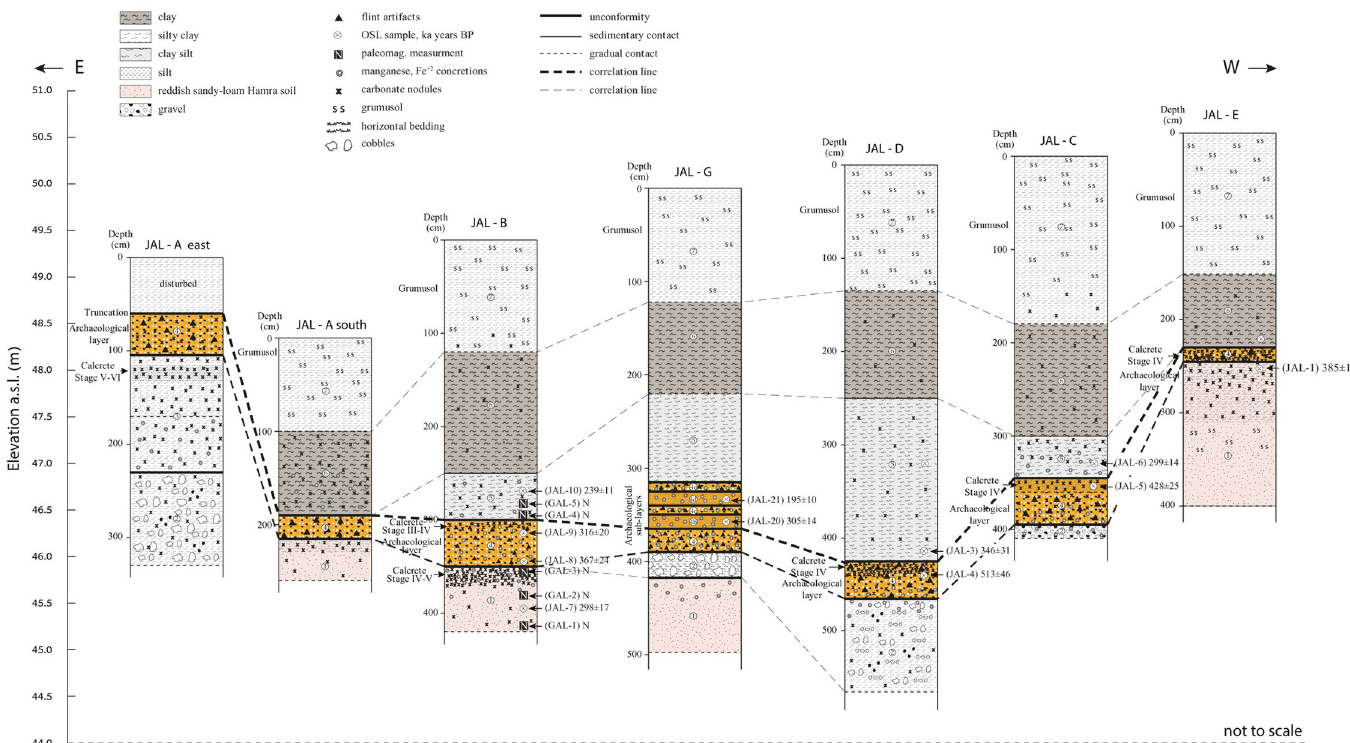
Fig 2. The stratigraphy of the site of Jaljulia as displayed in all sampled sections, as well as the sampling locations for absolute dating and for paleomagnetic stratigraphy.